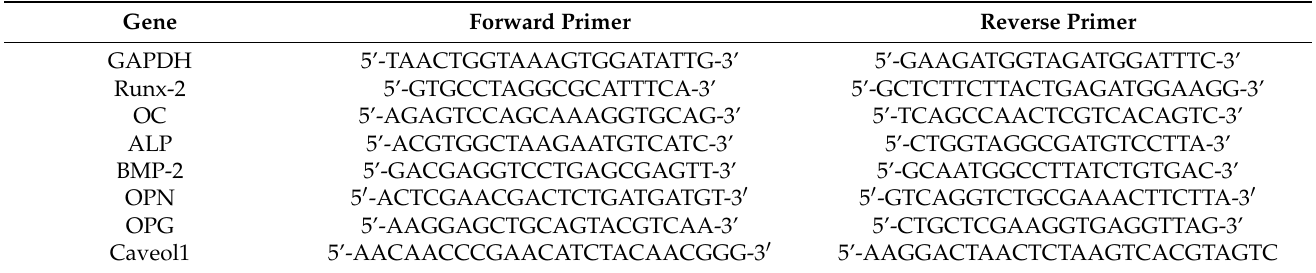
Table 1. Primers for PCR